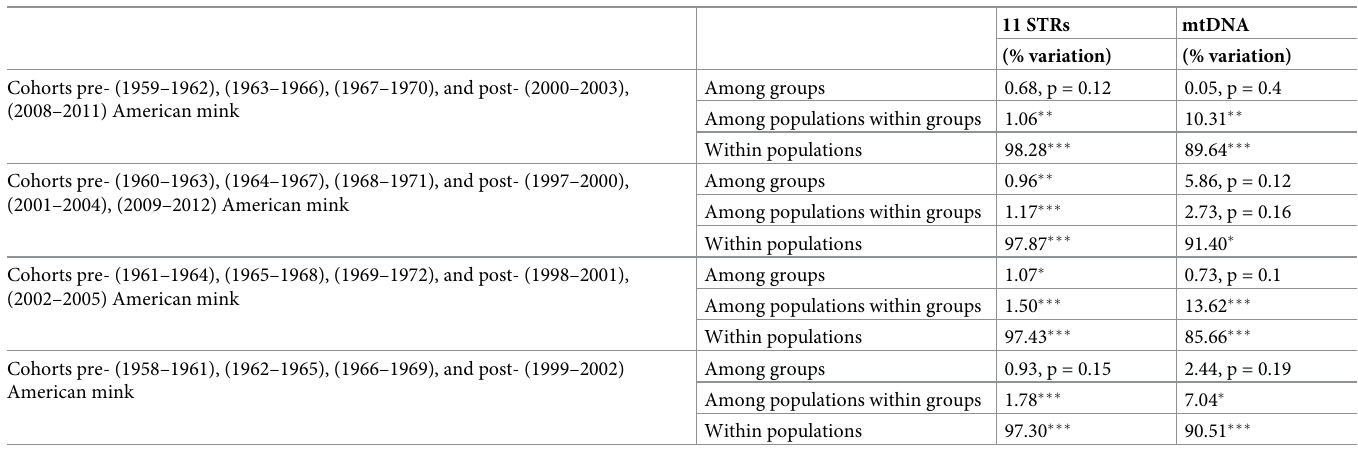
Table 3. Analyses of AMOVA. Groups indicate pre- or post-American mink invasion populations. Populations in the table refer to the different